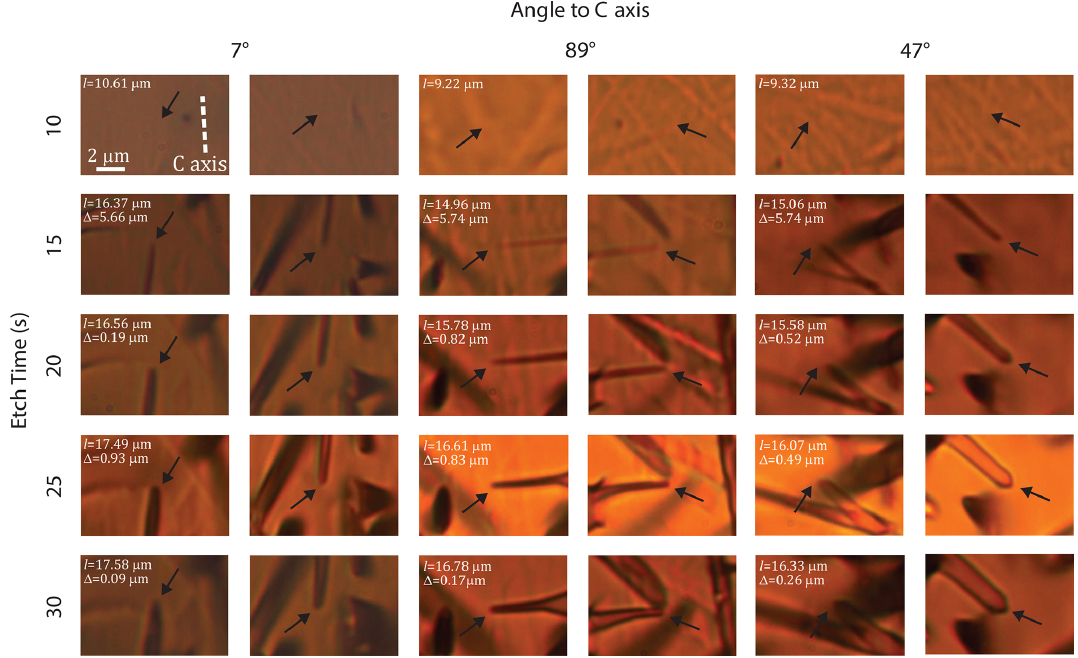
Figure 9. Transmitted-light microscope images of the tips of three unannealed induced fission tracks at different crystallographic angles through progressive etching steps; pictures are paired left–right, showing each tip of the same track separately. The scale and orientation in the top left apply to all images. Etch times are since the beginning of etching, although it is unknown exactly when each track was intersected and began to